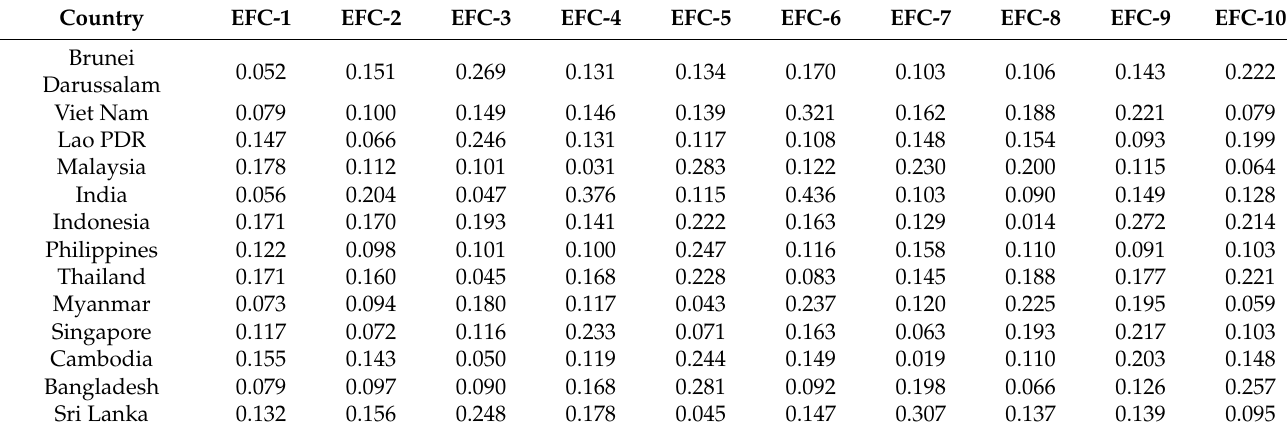
Table A7. The defuzzied SF decision matrix.